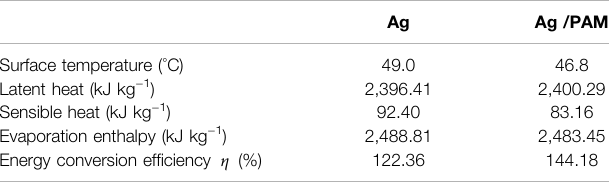
TABLE 1 | The energy conversion ef fi ciency of Ag and Ag/PAM materials under TABLE 2 | The surface temperature, latent heat, sensible heat, evaporation one Sun irradiation with pure water and seawater. enthalpy,and energyconversion ef fi ciencyofAgand Ag/PAMmaterialsunder one Sun irradiation with pure water. Ag